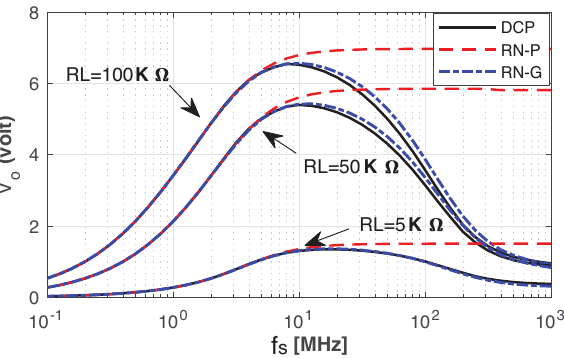
Figure 16. SPICE simulation of the output voltage at different switching frequencies and loads for the switching DCP circuit, RN-P model, and RN-G model.